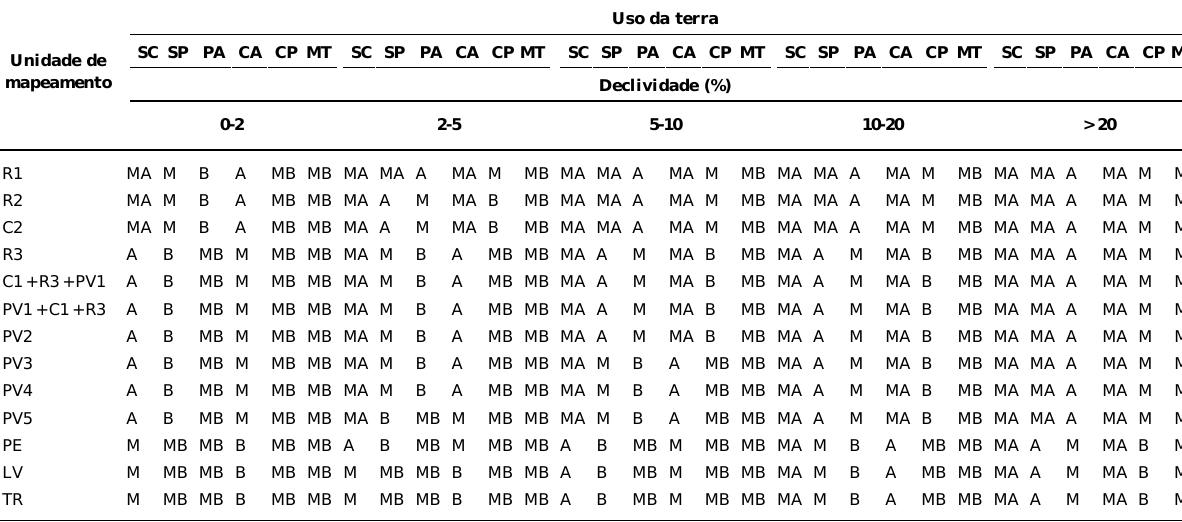
SC: sem cobertura; SP: culturas semiperenes; PA: pastagem; CA: culturas anuais; CP: culturas perenes; MT: floresta nativa e, ou, reflorestamento; MB: risco muito baixo; B: risco baixo; M: risco médio; A: risco alto; MA: risco muito